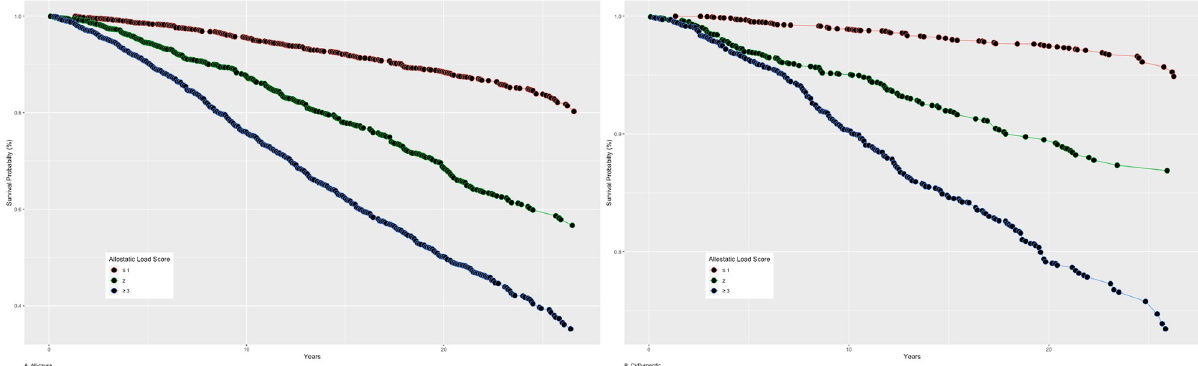
Fig 1. Kaplan-Meier curves for A) all-cause and B) CVD-specific mortality risks according to allostatic load score categories: NHANES III-Linked Mortality File, 2015 (P-values for log-rank test < 0.001).